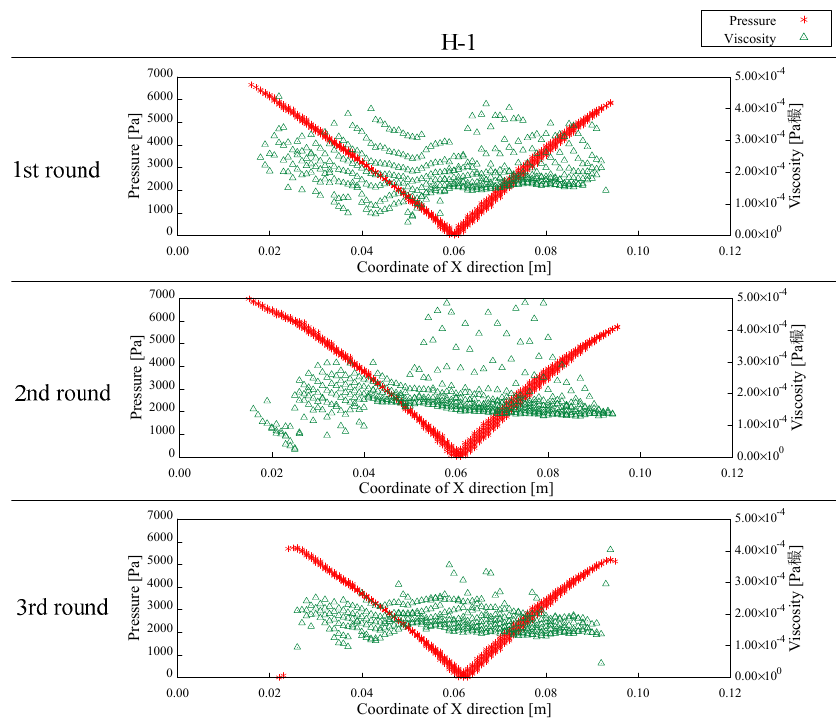
Figure 20. Comparison of the values of the pressure and viscosity coefficient from the simulation results of H-1.